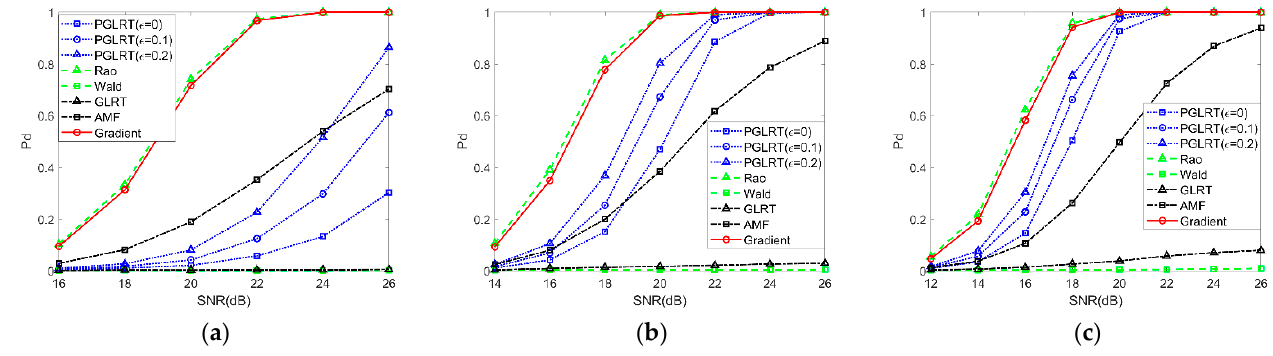
Figure 2. P versus SNR for d Figure 2. P d versus SNR for N = 16, cos 2 θ = 0.16: ( a ) K = 24; ( b ) K = 32; ( c ) K = 40.